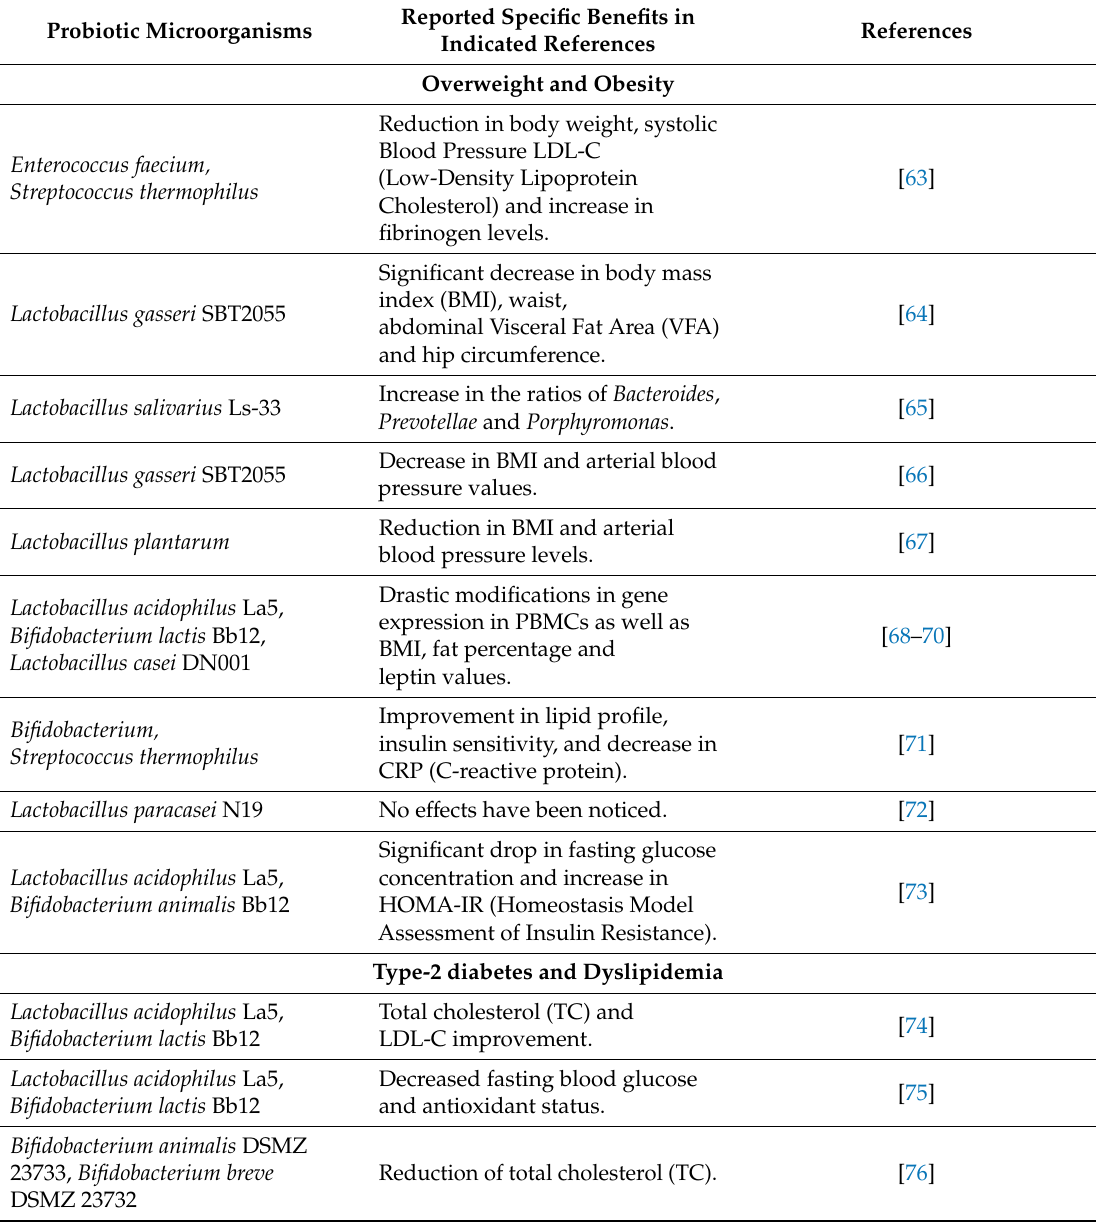
Table 3. Clinical studies and the e ff ect of probiotic administration on human